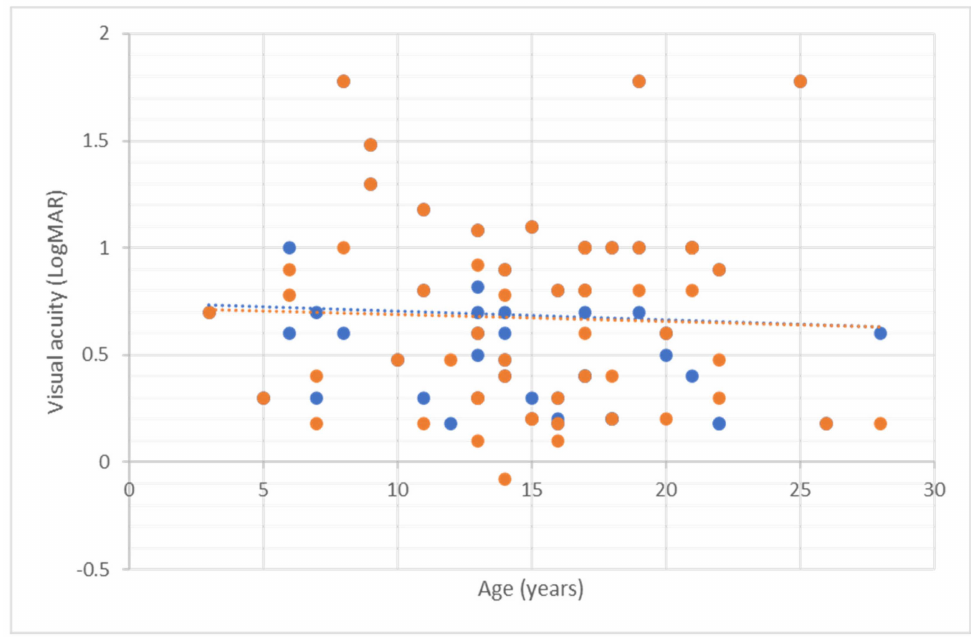
Figure 2. Mean visual acuity against age (in years) for all patients. Blue dots represent the right eye and orange dots represent the left